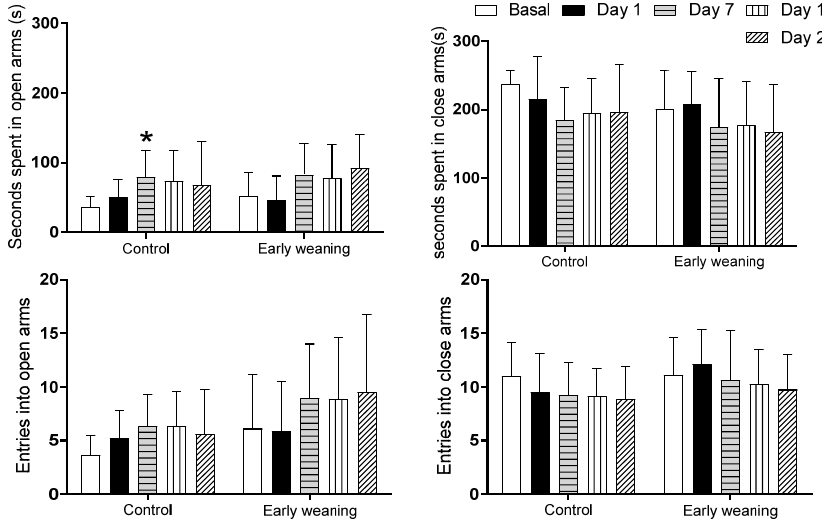
Figure 3. Effect of Early Weaning associated with chronic stress over time spent in open and closed arms (two upper figures) and over number of entries into open and closed arms (two lower figures) of the elevated plus maze. Data were obtained from animals during their 166–168 days of age (basal analysis) and on days 1 (168–170 days of age), 7 (174–176 days of age), 14 (181–183 days of age), and 21 (187–189 days of age) of alimentary stress. Two-way ANOVA and Bonferroni’s post hoc test n = 8. Data expressed as mean ± SD. * p < 0.05 vs. Basal.